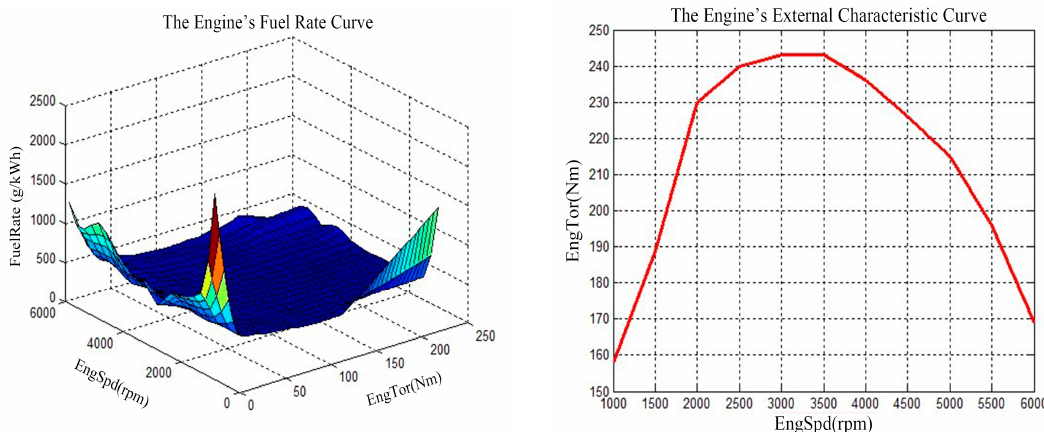
Figure 2. Engine fuel consumption rate curve and external characteristic curve.